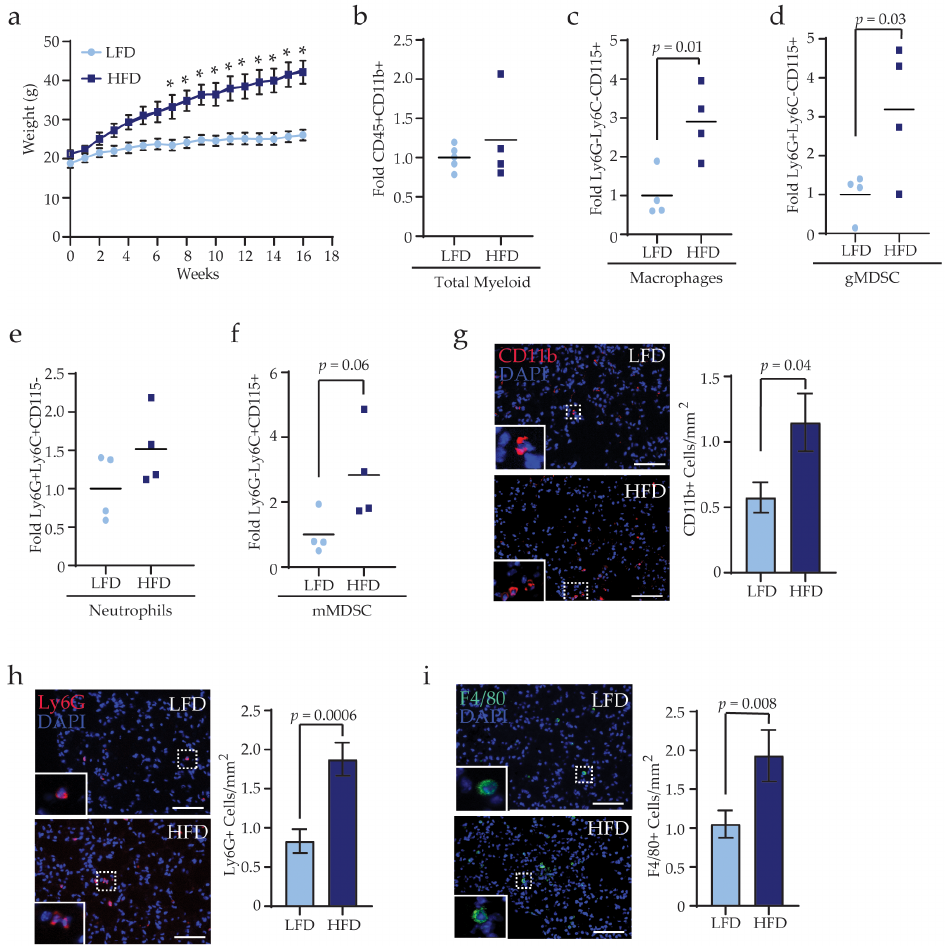
Figure 3. Obesity alters the compliment of myeloid lineage cells in lungs prior to metastasis. ( a ) Weight gain of female mice fed either LFD or HFD for 16 weeks (n = 8 mice/group, * p < 0.05). Flow cytometry quantification of CD45 + CD11b + myeloid lineage cells ( b ), Ly6G − Ly6C − CD115 + macrophages ( c ), Ly6G + Ly6C − CD115 + gMDSC ( d ), Ly6G + Ly6C + CD115 − neutrophils ( e ), and Ly6G − Ly6C + CD115 + mMDSC ( f ). Results were normalized to CD45 + CD11b + cells and expressed as fold change compared to controls (n = 4 mice/group). Quantification of CD11b + myeloid lineage cells ( g ), Ly6G + neutrophils and gMDSCs ( h ), and F4/80 + macrophages ( i ) in lungs of LFD- and HFD-fed mice (n = 5 mice/group). Magnification bars = 50 µ